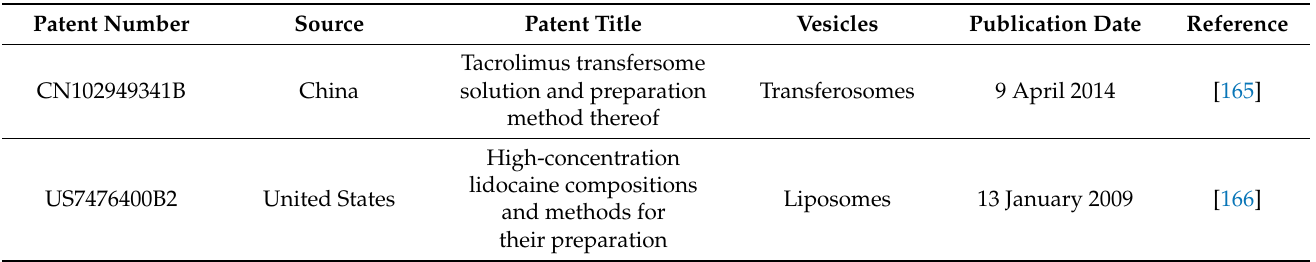
Table 11. Examples of patent innovations for the application of vesiculosomes in burn